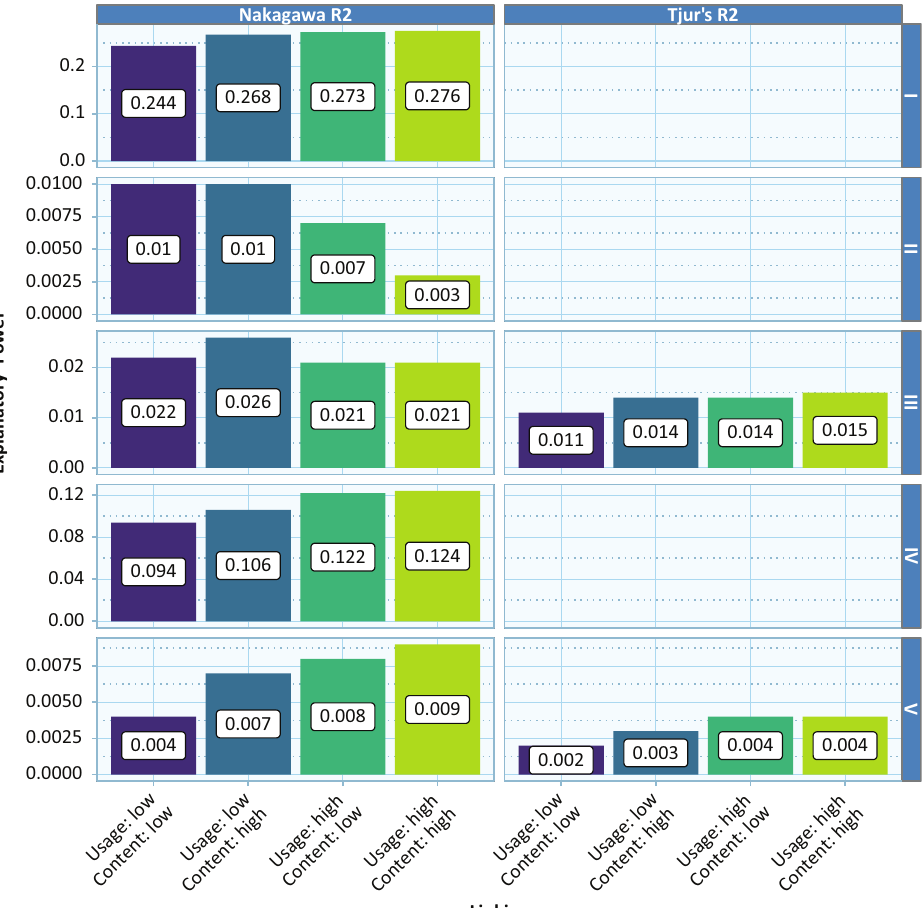
ation in individual salience change of issues. In the longitudinal design (II) the explanatory power is even lower. However, it is a special case, as the inclusion of a lagged dependent variable eats up a lot of the variation, leaving little unexplained variation that news exposure could help explain (Figure A5 in the Supplementary File, Conditional R²).